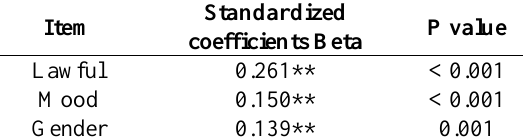
Table 9. Predictors of factor 4 (aggressive